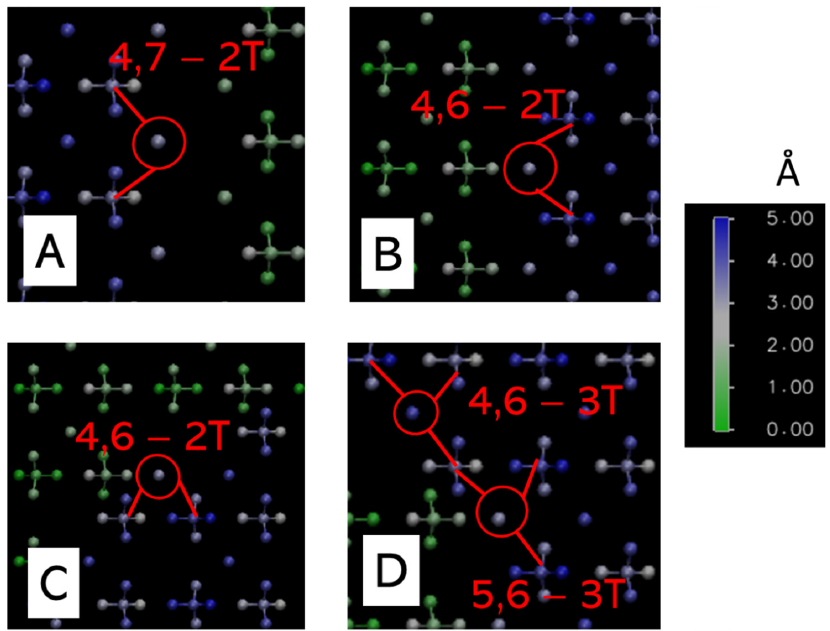
Figure 7. Coordination of Ba step sites. ( A ): left (slow) [010] step; ( B ): right (fast) [010] step; ( C ): segmented [120] step; ( D ): straight [210] step. “T” denotes here neighbors belonging to the uppermost terrace, the number before “T” denotes the number of those neighbors; N,M notation refers to the number of Ba-O-S and Ba-O-Ba bonds.